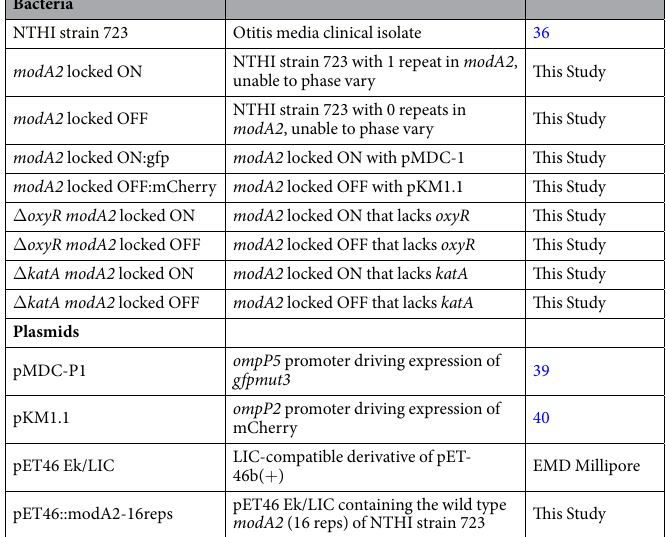
Table 1. List of bacteria and plasmid used in this